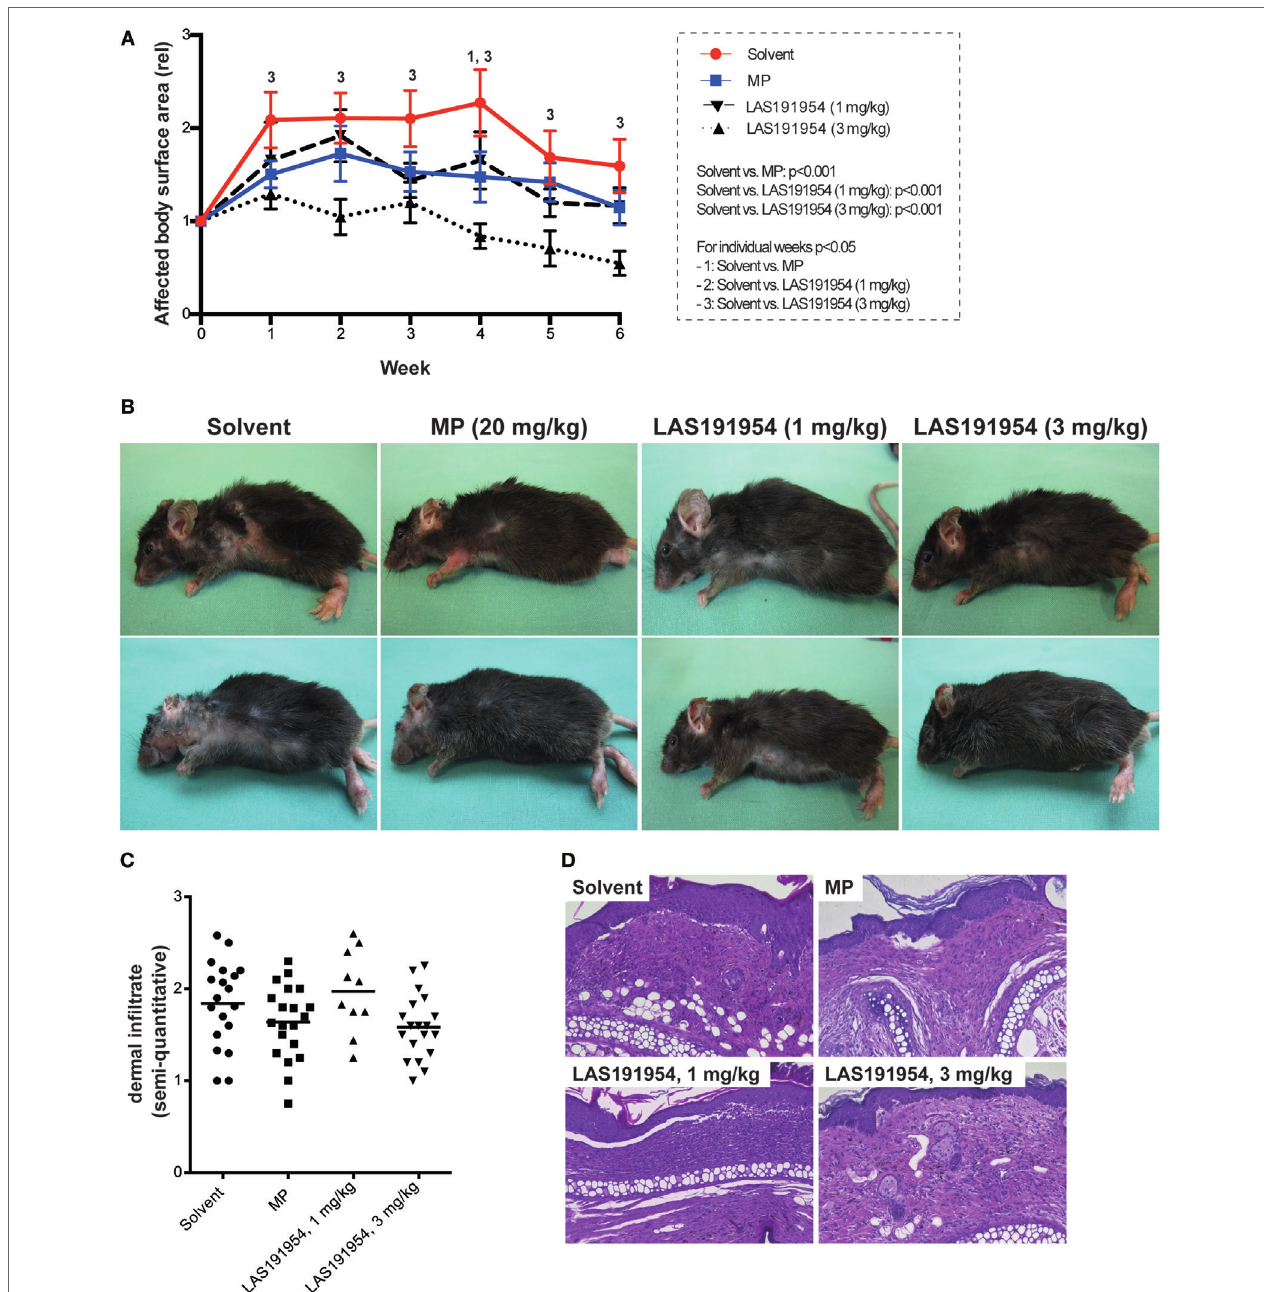
FigUre 1 | Pharmacological PI3K δ inhibition improves already clinically manifested experimental Epidermolysis bullosa acquisita (EBA). B6.s mice were immunized with COL7 for induction of experimental EBA. When skin lesions affected 2% or more of the body surface area, individual mice were randomly allocated to one of the four treatment groups. (a) Clinical disease severity, expressed as affected body surface area in relation to the time of allocation to treatment (week 0). Data are based on 11 mice per group, with the exception of LAS191954 1 mg/kg [ n = 6; two-way ANOVA (taking time and treatment as variables) with Holm-Sidak posttest]. The global p values of testing solvent versus the treatments is given in the box on the left. For the posttest, p values < 0.05 are indicated by numbers, whereas “1” indicates a difference between solvent and methylprednisolone (MP), “2” a difference between solvent and LAS191954 (1 mg/kg), and “3” a difference between solvent and LAS191954 (3 mg/kg). (B) Representative clinical images of two mice from each group taken at the end of the experiment. (c) Semiquantitative evaluation of the dermal infiltrate of the ears at week 6 of the experiment, with 0 indicating no, 1 mild, 2 moderate, and 3 severe infiltration. While a tendency toward lower infiltration scores was noted in MP and LAS191954 (3 mg/kg), this was not statistically significant. Each datapoint represents one ear per group (if possible, both ears were evaluated). Statistical significance was calculated using ANOVA. (D) Representative H&E-stained sections from all treatment groups at week 6 of treatment. Original magnification 200 ×